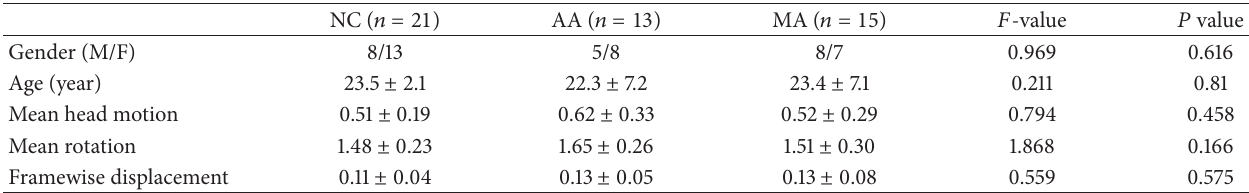
Table 1: Demographic, clinical, and neuropsychological data on normal sighted subjects (NC), anisometropic amblyopia (AA) subjects, and mixed amblyopia (MA)